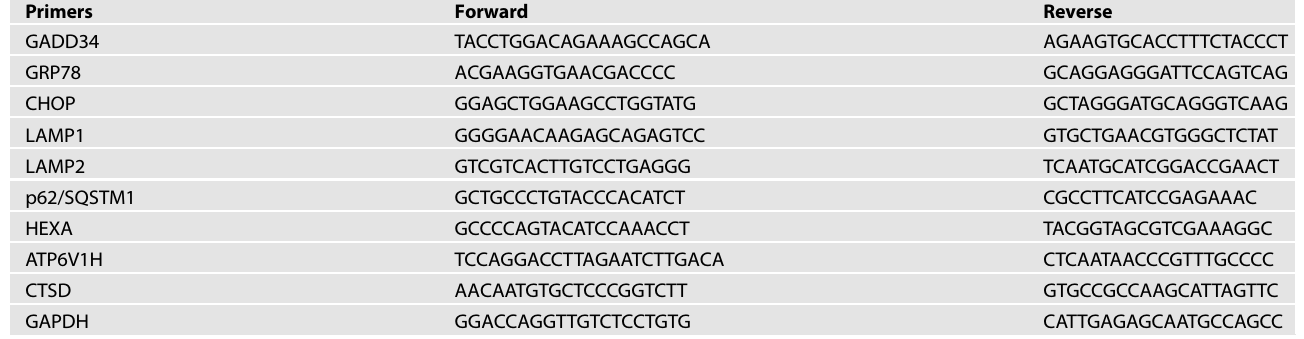
Table 1. Rat primers used for the quantitative